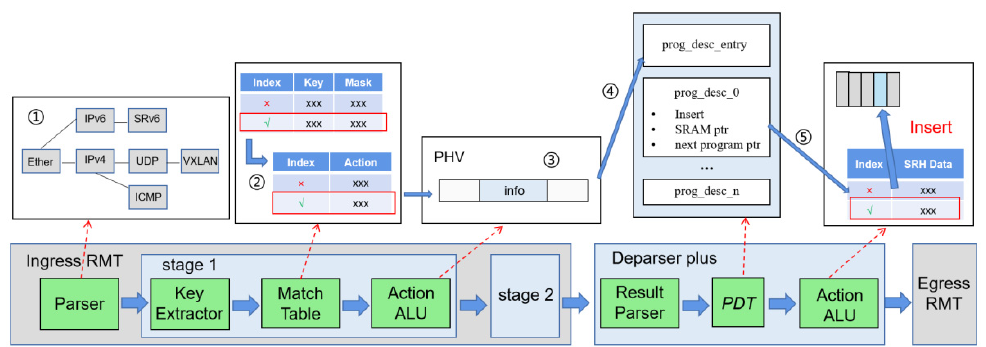
Figure 2. Example of PDT